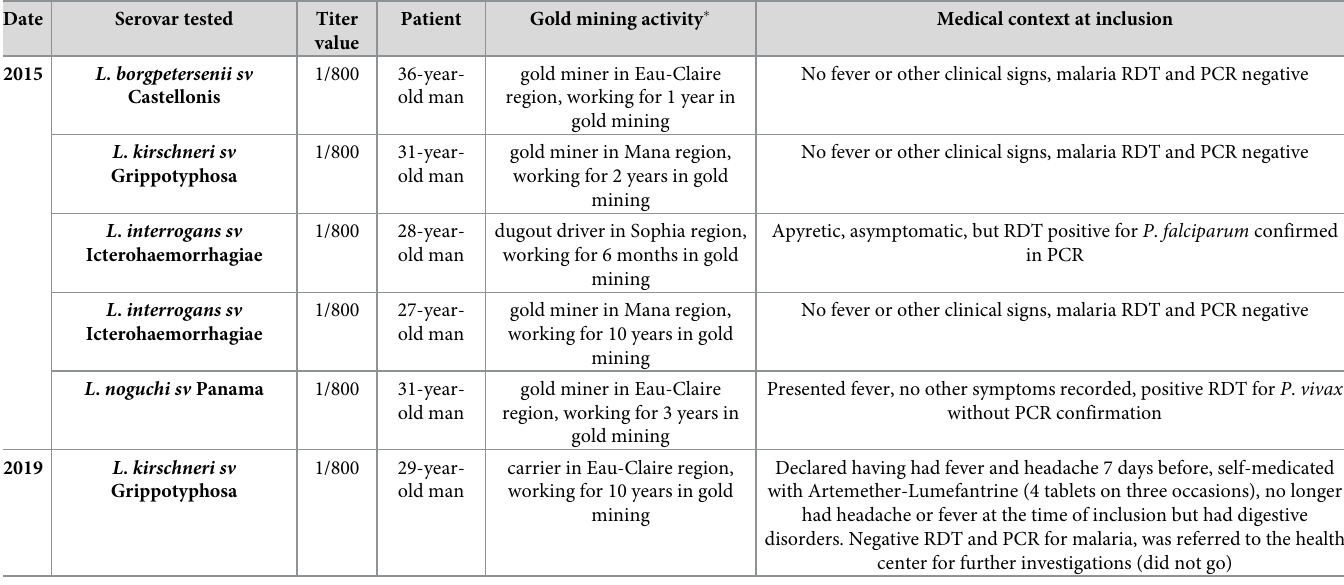
Table 3. Serovars, medical context ang gold mining activity of the six participants with antibodies titers for leptospirosis > = 1/800, French Guiana, 2015 and